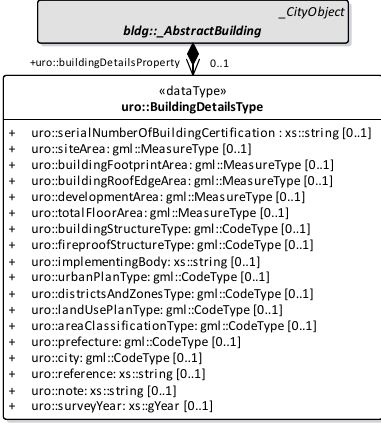
Figure 5. A part of the UML class diagram of the Urban Object